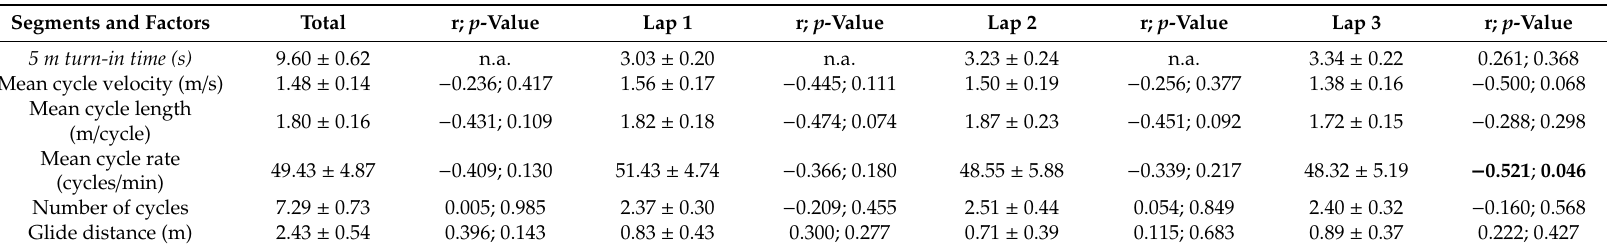
Table 5. Descriptive statistics (mean ± standard deviation) and partial correlation analysis of 5 m turn in segment time with underlying components. Segments and Factors